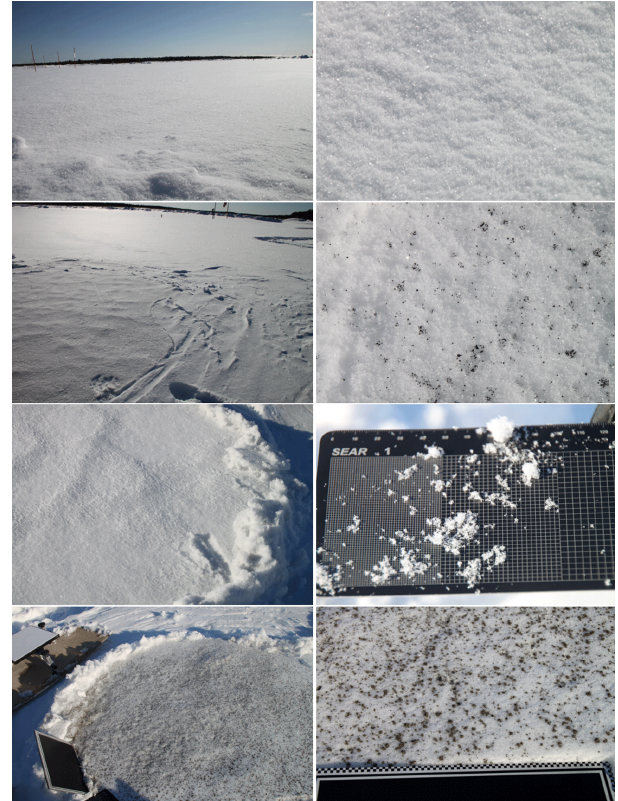
Figure 3. Photographs of the samples. On the left is an overview; the right shows some details. Starting from the top photographs, clean snow on 4 April 2013 is shown, snow deposited with volcanic ash on 3 April 2013, snow deposited with chimney soot on 4 April 2013, and on the bottom, snow deposited with glaciogenic silt on 4 April 2013 is